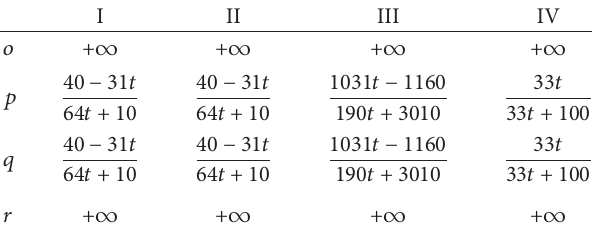
Table 3: Important values of nodes in different ranges.